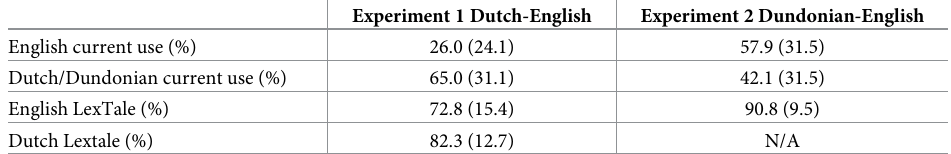
Table 1. Overview of the demographic information (SD in brackets) for participants in the Dutch-English (Exper- iment 1) and Dundonian-English (Experiment 2)